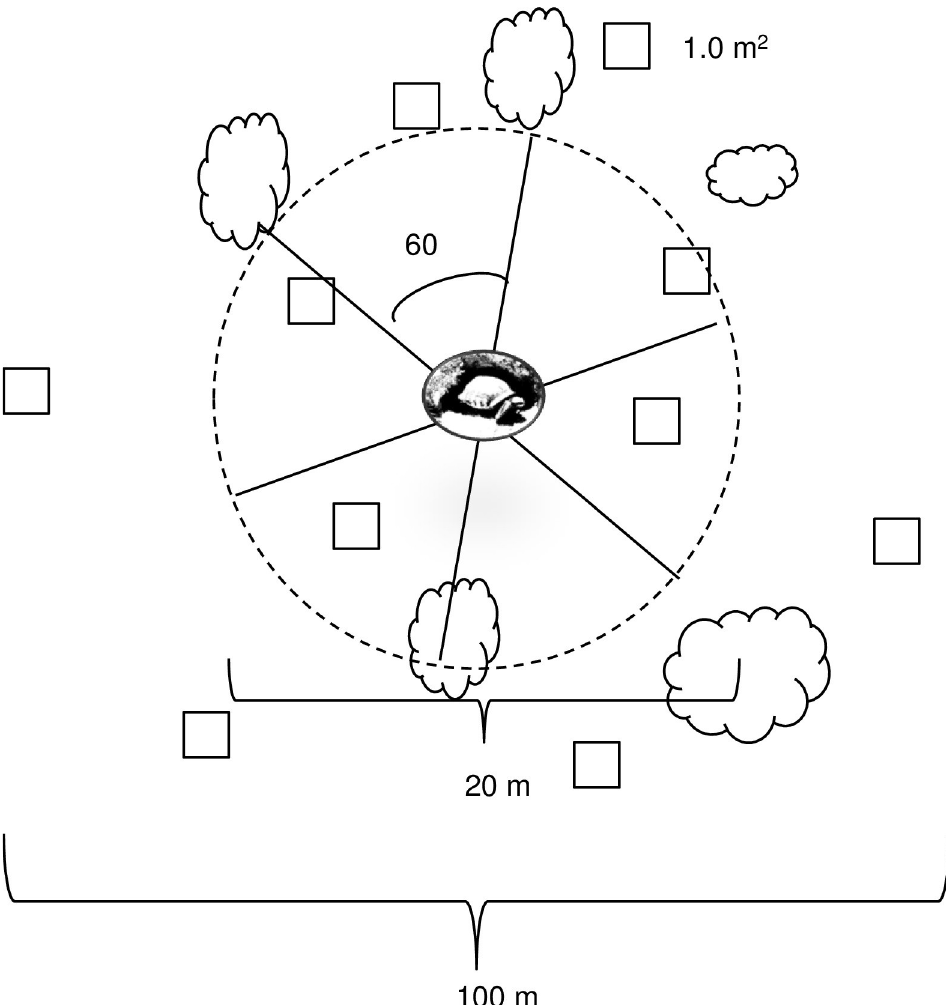
Fig 2. Habitat sampling design. The habitat sampling design for used (female tortoise burrow) or available (paired control) habitat sampling locations in Mojave National Preserve. We created a transect array composed of six (10 m) transects to measure perennial cover. Within a radius of 50 m, we sampled annual vegetation at 10 randomly selected points using a 1 m 2